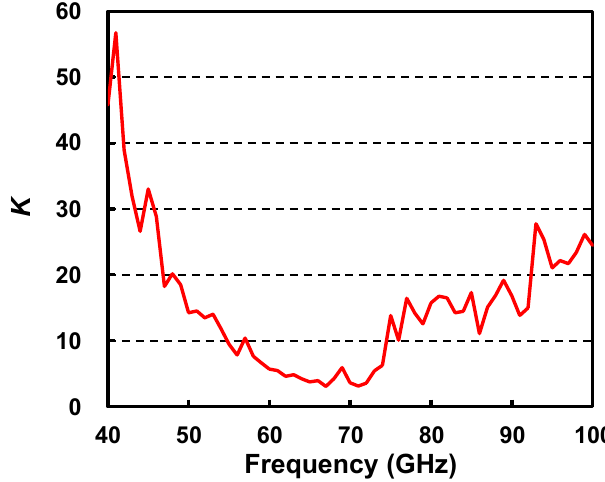
Figure 8. Measured stability factor K versus frequency.